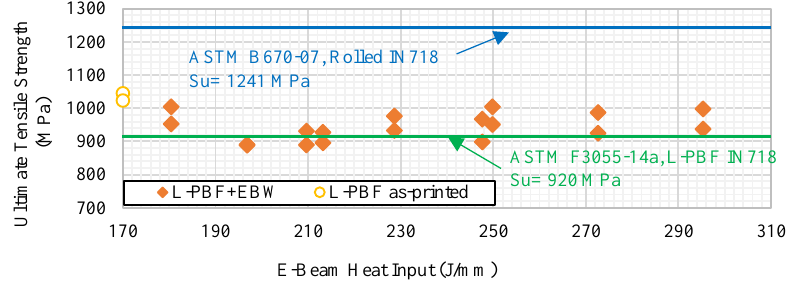
Figure 14: Effect of heat input on UTS of the EBW’ed samples